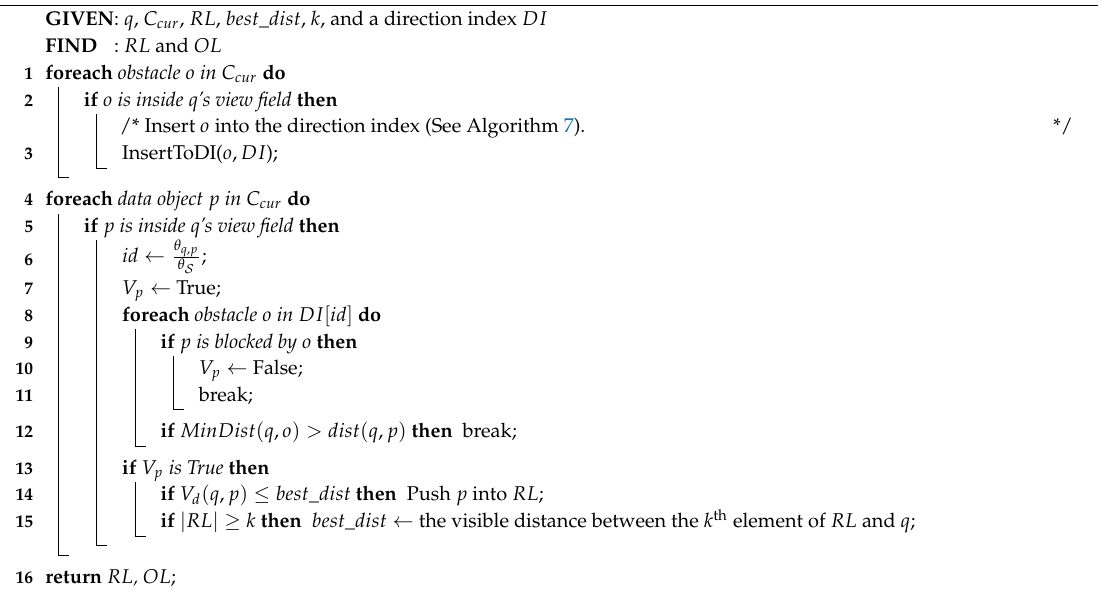
Algorithm 6. Visibility Check ver. 3 (VC3) algorithm (visibility check algorithm based on Theorem 1).